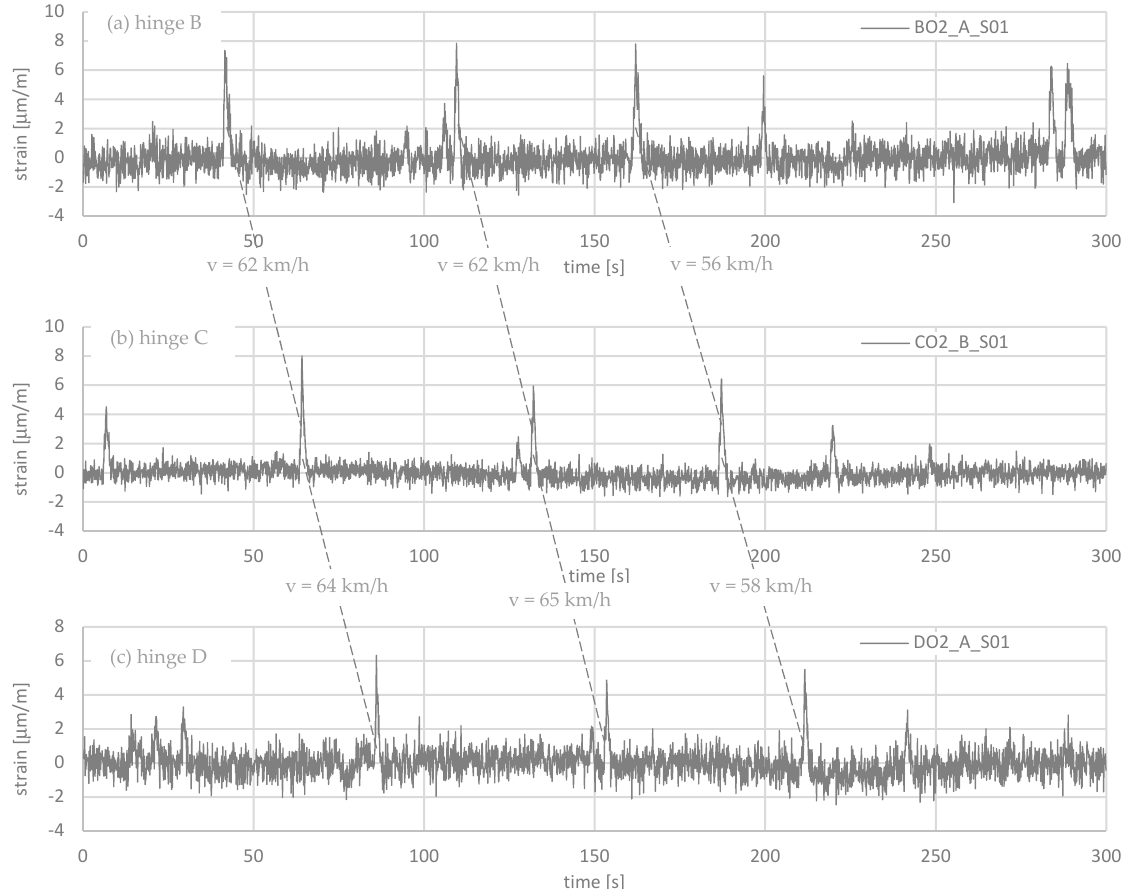
Figure 5. Strain measurement over a period of 5 min with a sampling rate of 1/10 s: ( a ) Gerber hinge B; ( b ) Gerber hinge C; ( c ) Gerber hinge D. The distance between the Gerber hinges is 390 m.